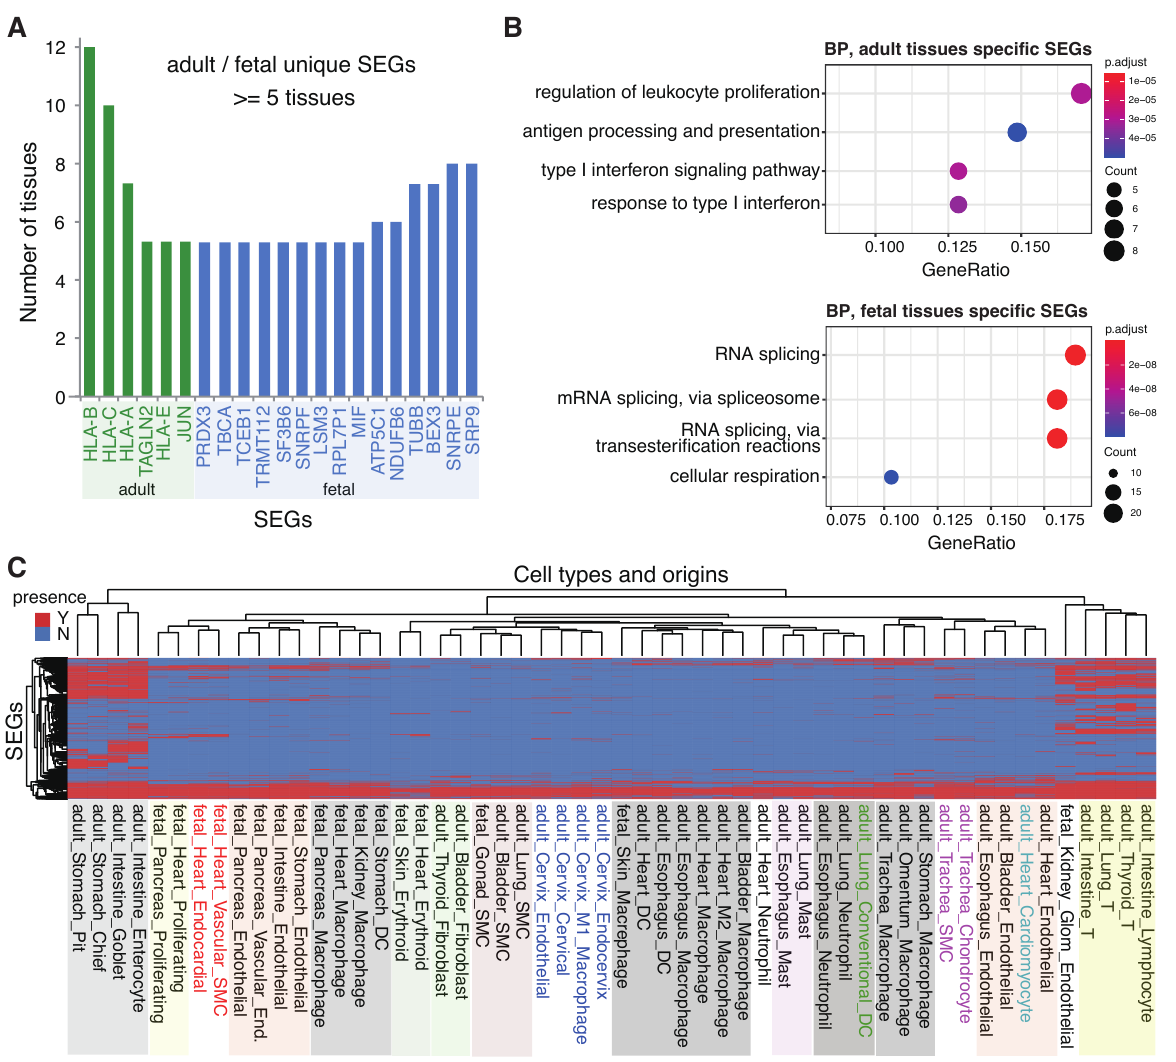
Figure 3. Development- and cell-specific SEGs. ( A ) SEGs specific to human adult tissues and fetal tissues. The adult-specific SEGs were identified from at least five adult tissues but none of the fetal tissues, and vice versa for the fetal-specific SEGs. ( B ) Functional enrichment for the development- specific SEGs. For the enrichment analysis, the adult-specific SEGs were identified from at least two adult tissues but none of the fetal tissues, and vice versa for the fetal-specific SEGs. Gene ontology biological process (BP) terms were used and Fisher exact tests with Bonferroni correction were performed. ( C ) Clustering of within-tissue cell-type SEGs. Genes and cell types were represented in rows and columns, respectively. The value for the heatmap cells was set as ‘Y’ (red) if the SEG was present for the corresponding cell type, and ‘N’ (blue) otherwise. Cell types clustered apparently were shown in colored